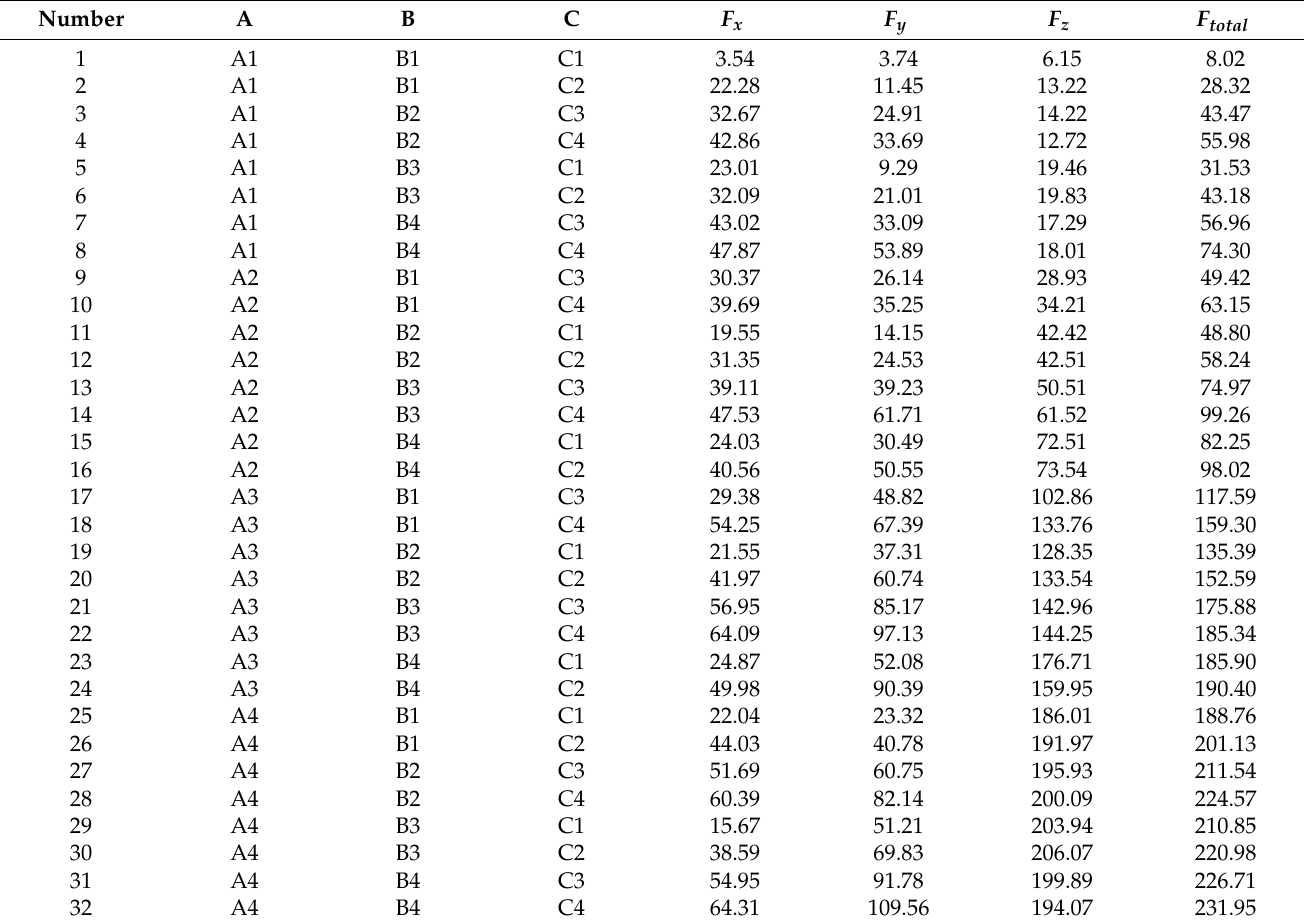
Table 4. Orthogonal experimental